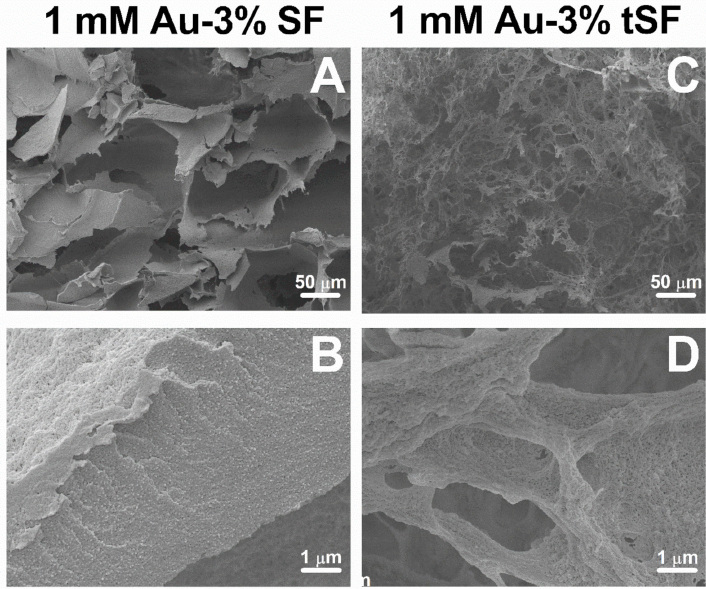
Figure 5. SEM images of the lyophilized 1 mM Au-3% SF ( A , B ) and 1 mM Au-3% tSF ( C , D )